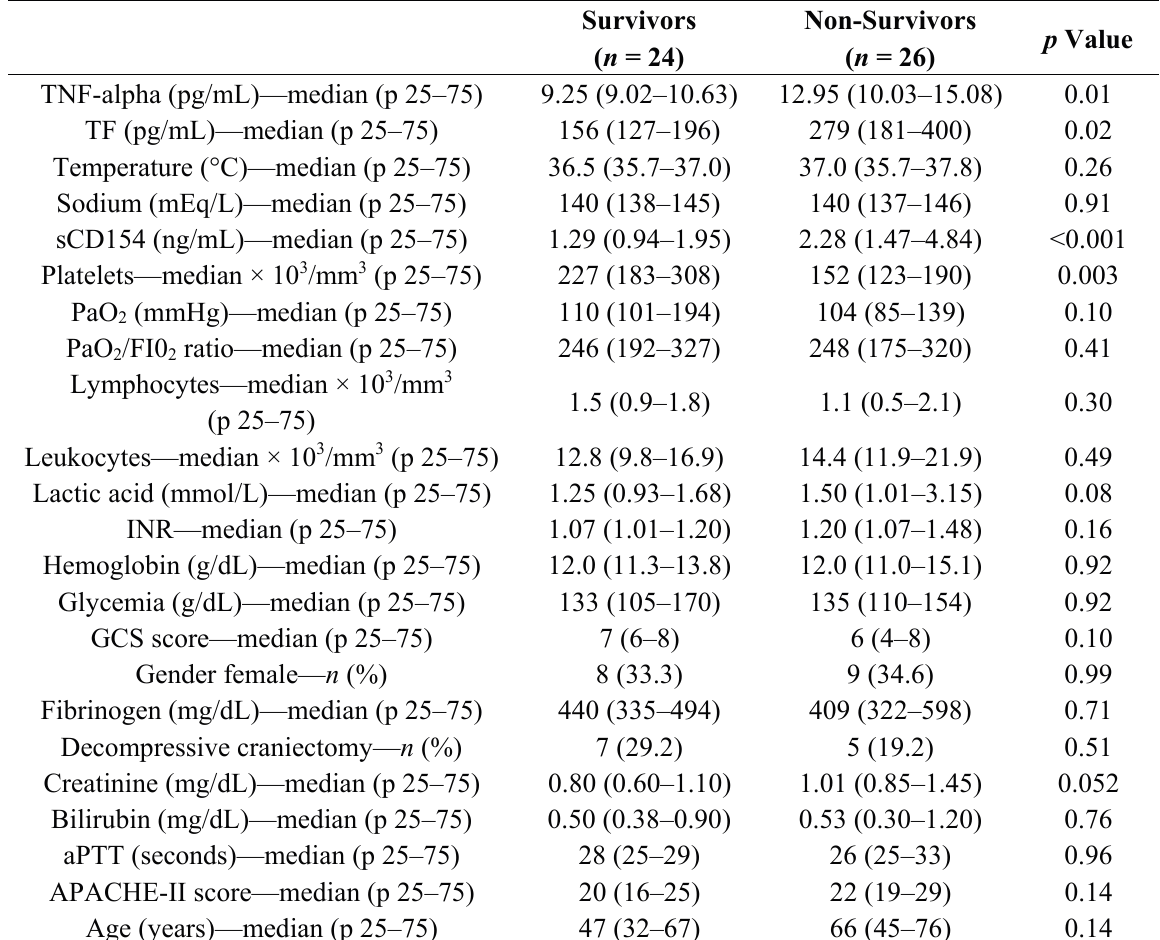
Table 2. Clinical and biochemical characteristics of MMCAI patients according to 30-day